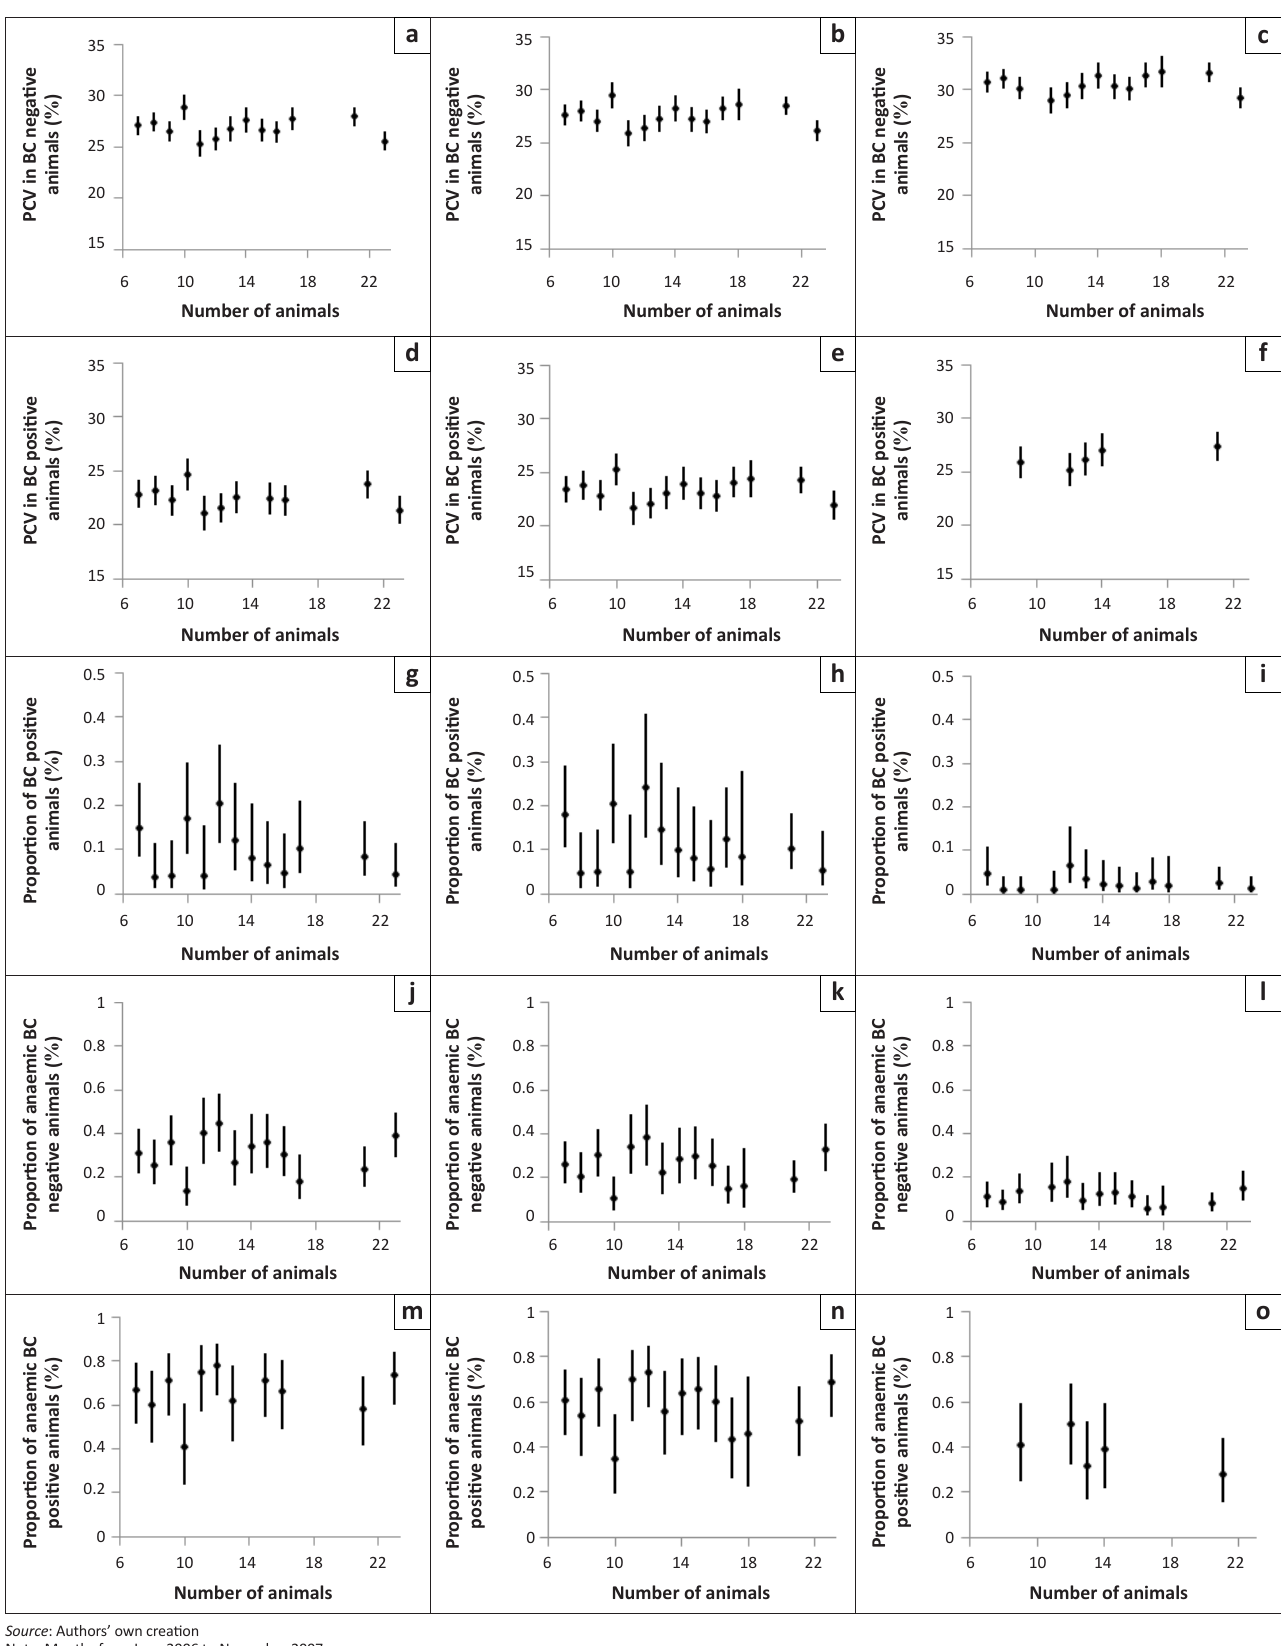
FIGURE 3: Comparing herd average packed cell volume, trypanosomes herd average prevalence and herd average anaemia in positive and negative cattle at the three diptanks, (a, d, g, j, m) Ekuphindisweni, (b, e, h, k, n) Mvutshini and (c, f, i, l, o) Ocilwane (estimates and 95 % confidence intervals without interaction between explanatory variables)